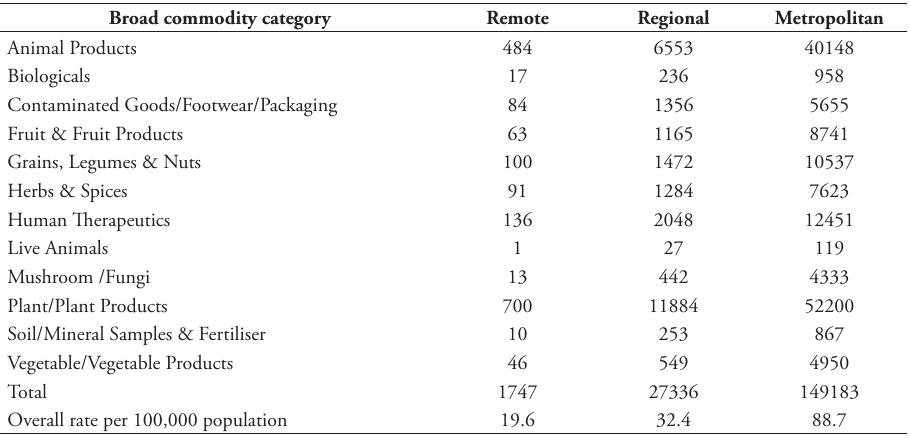
Table 2. Counts of seizures from 2008–2011 by broad commodity category and region.